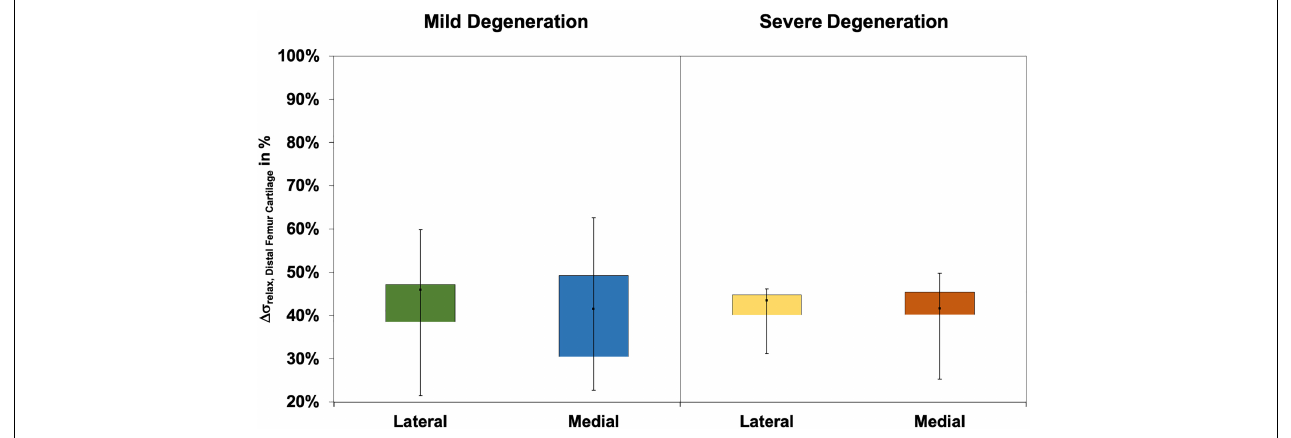
FIGURE 9 | Box plots (minimum, maximum, median, and 25th and 75th percentiles) of the relaxation percentages over the maximum stress ( (cid:49) σ relax ) of the mildly and severely degenerated distal femur articular cartilage (AC). Non-parametric statistical analyses: n =